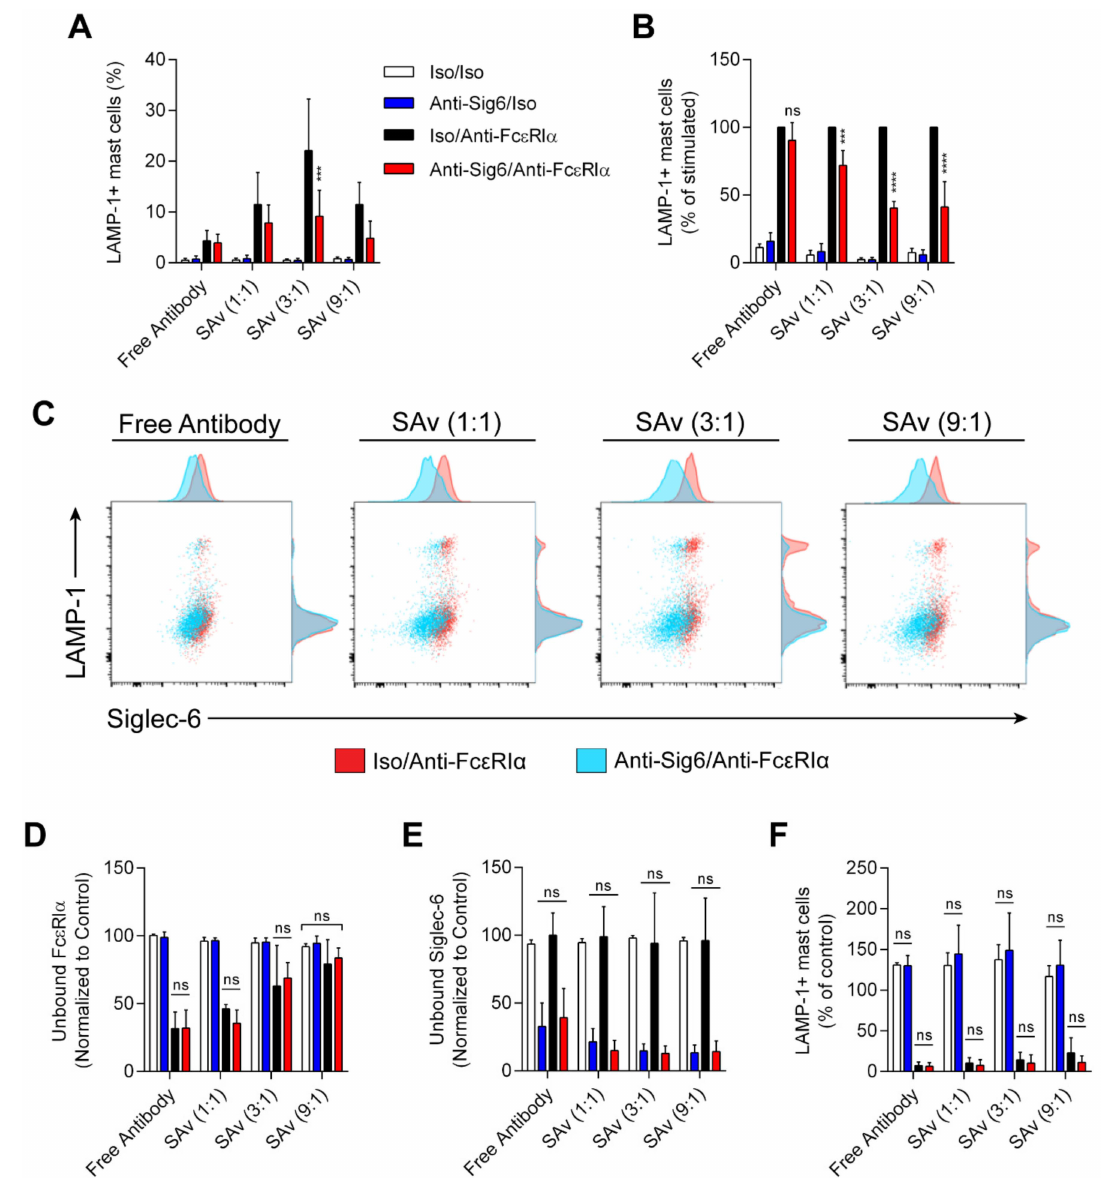
Figure 6. Inhibition induced by co-engagement of Siglec-6 and Fc ε RI α does not depend on reduced Fc ε RI α crosslinking. Streptavidin complexes (SAv) with the indicated ratio of anti-Siglec-6 to anti- Fc ε RI α or uncomplexed antibody with final concentrations matching that of the 1:1 SAv complexes were used to stimulate HSMCs. After 30 min, the cells were washed, stained, and analyzed by flow cytometry. MCs were pre-gated on live CD117+ cells. The percentage of MCs expressing surface LAMP-1 ( A ), LAMP-1 normalized to the Iso/Anti-Fc ε RI α sample in each group ( B ), and dot plots comparing stimulated samples with anti-Siglec-6 or isotype control mAb with respect to surface LAMP-1 and unbound Siglec-6 expression ( C ) are shown. Unbound Fc ε RI α ( D ) and unbound Siglec-6 ( E ) normalized to the control are quantified based on sample MFI. ( F ) Approximately 24 h after initial stimulation as indicated, cells were stimulated with 500 ng/mL anti-Fc ε RI α and stained for LAMP-1 and MC markers. The percentage of LAMP-1+ HSMCs normalized to that of cells not initially treated with antibody is quantified. Data represent the means and standard deviations ( A , B , D – F ) or are representative ( C ) of four independent experiments using three distinct HSMC cultures. *** p < 0.001; **** p < 0.0001; ns, not statistically significant, determined by two-way ANOVA with Tukey test to correct for multiple